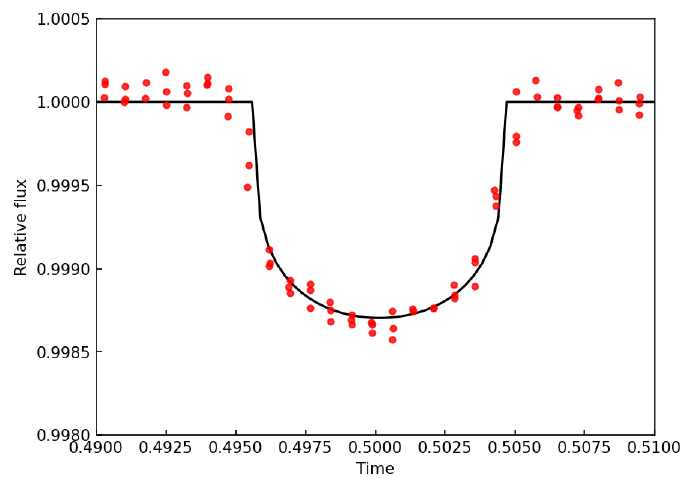
Figure 3. Mandel and Agol shape of the transits of K2-110 b. Red dots are the phased-folded light curve, and the black line is the Mandel and Agol model. Computed with